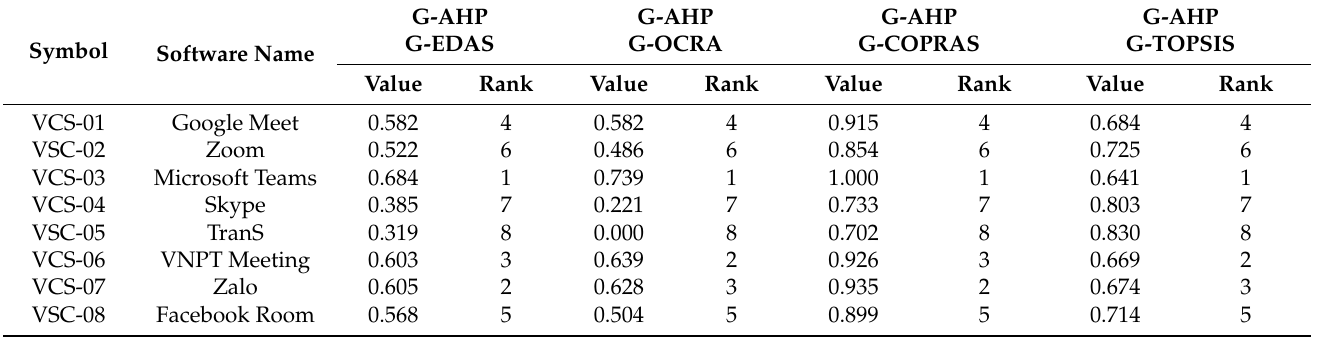
Table 11. Ranking of compared methods.